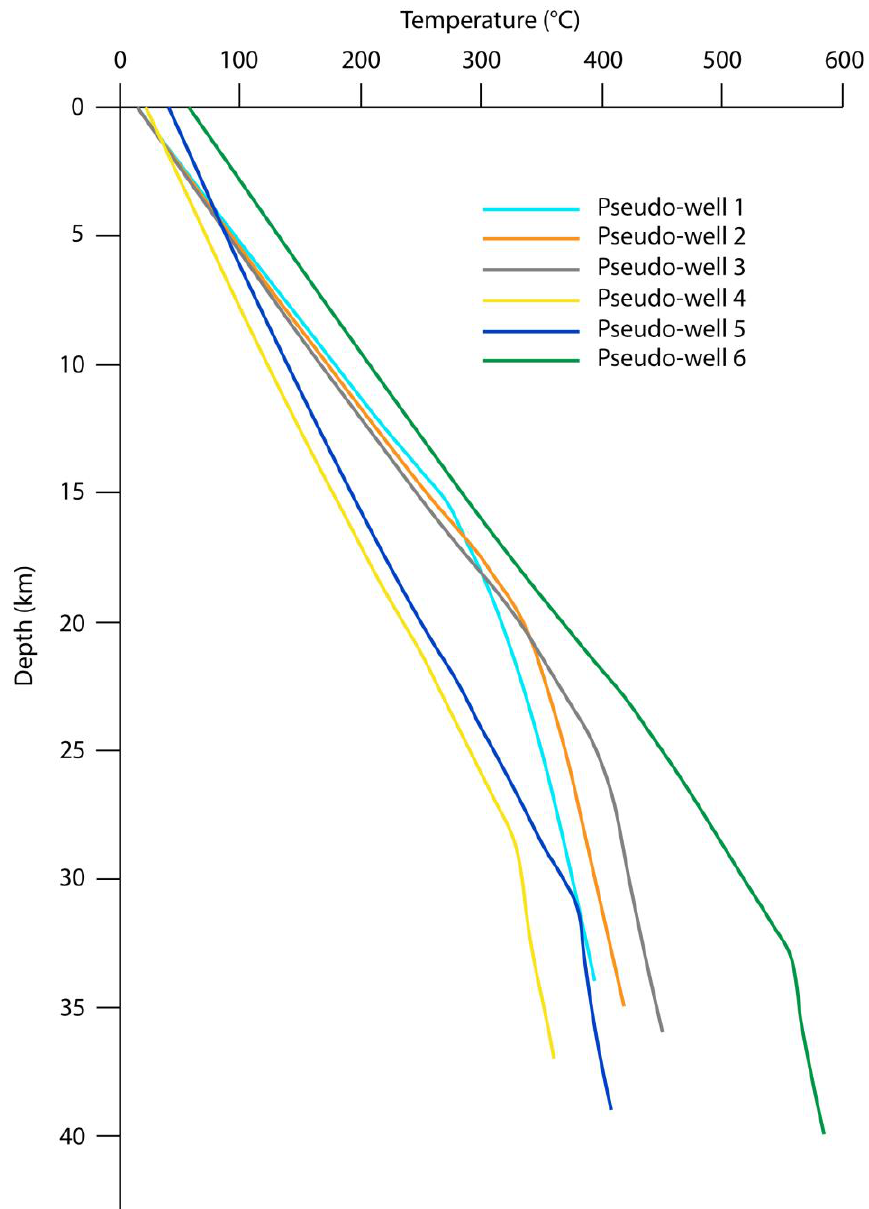
Figure 7. Calculated geotherms relative to the six pseudo-wells shown in Figure 6.